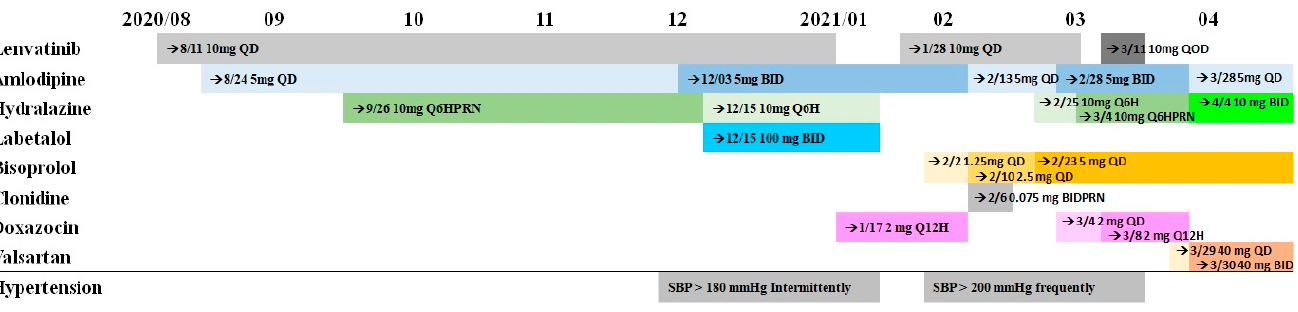
Figure 1. Timeline of the lenvatininb and anti-hypertensive agents